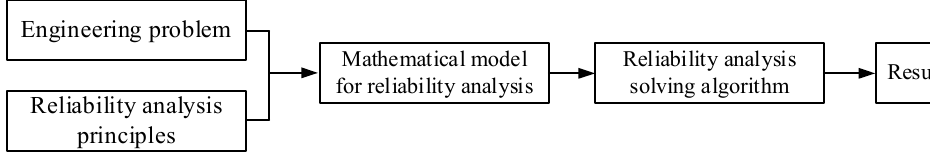
Figure 4. The general process of reliability analysis.